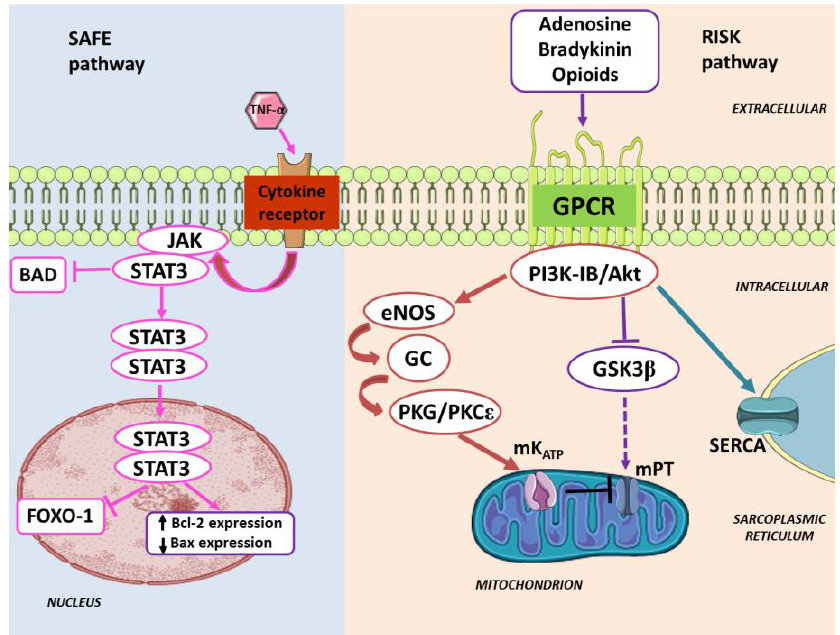
Figure 1. Major cardiac conditioning signaling pathways. The activation of cardioprotective signaling RISK, eNOS/PKG, and SAFE pathways by conditioning triggers is represented (modified